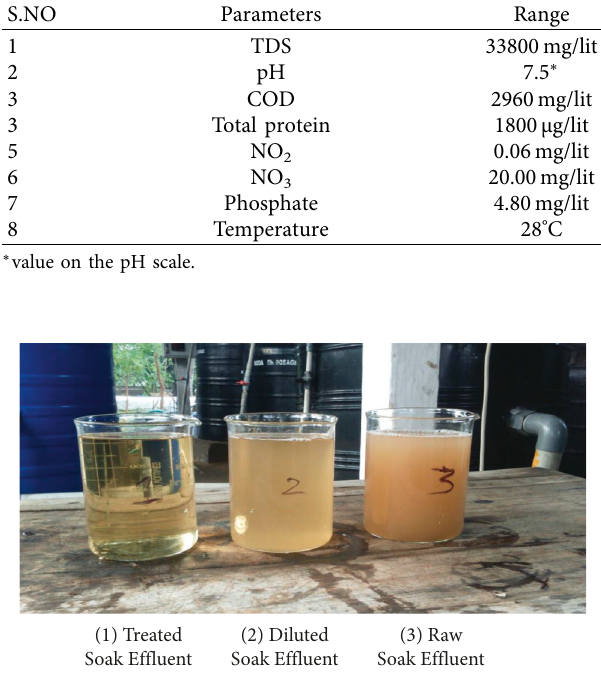
Figure 7: Treated soak effluents at 5 days retention time.